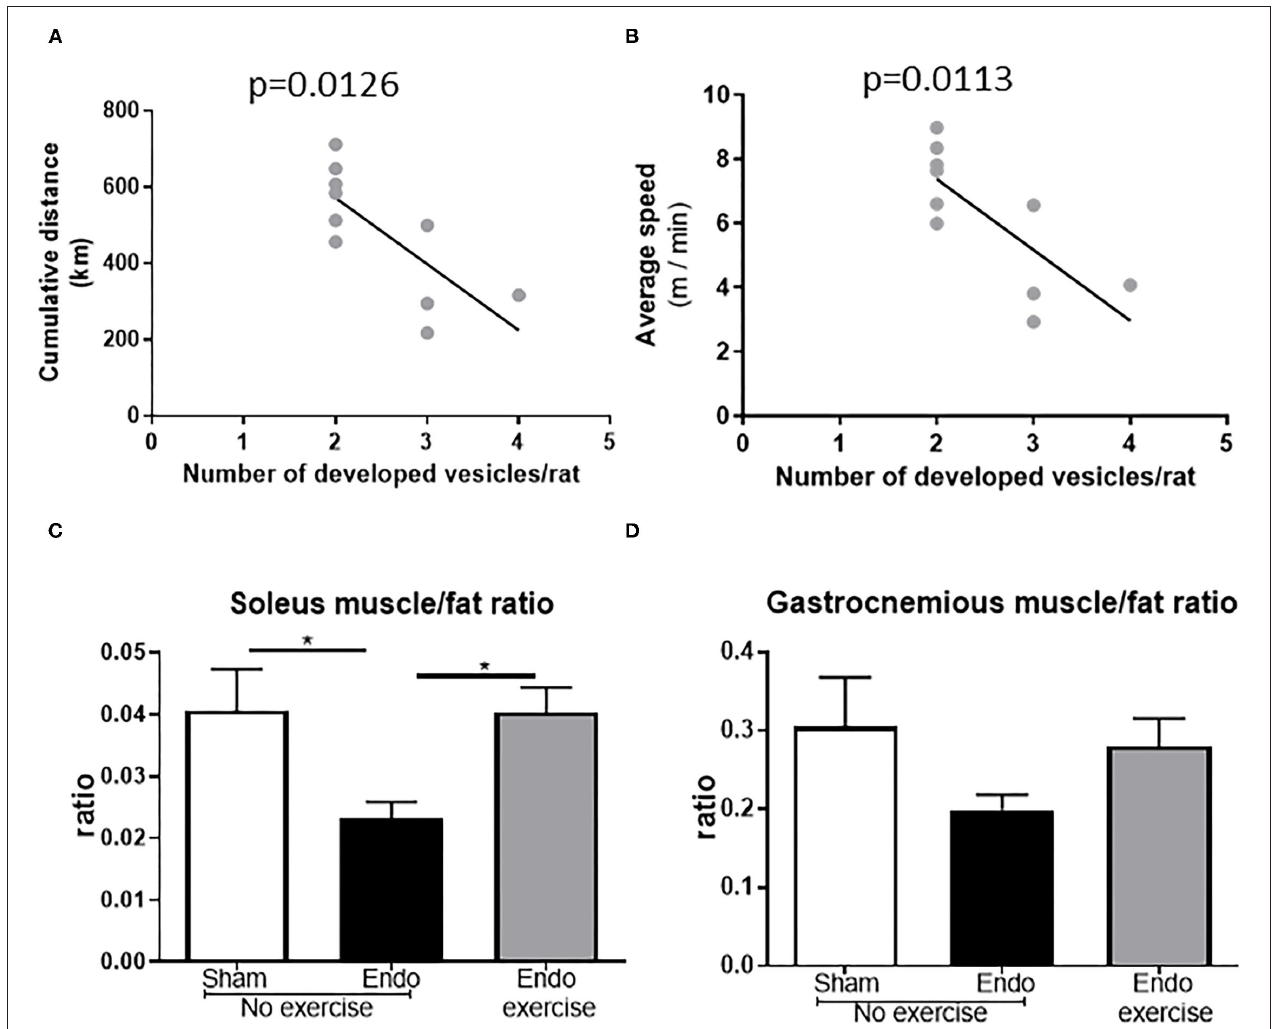
FIGURE 3 | Running parameters and muscles. (A) Endo-Exercise animals with higher cumulative distance between days 7 and 60 of the study protocol and (B) higher average speeds, developed significantly less vesicles. (C) Soleus muscle/fat and (D) gastrocnemius muscle/fat ratios increased in the Endo-Exercise animals when compared to the Endo-No exercise animals ( n = 9–10/group ± sem; * p < 0.05).